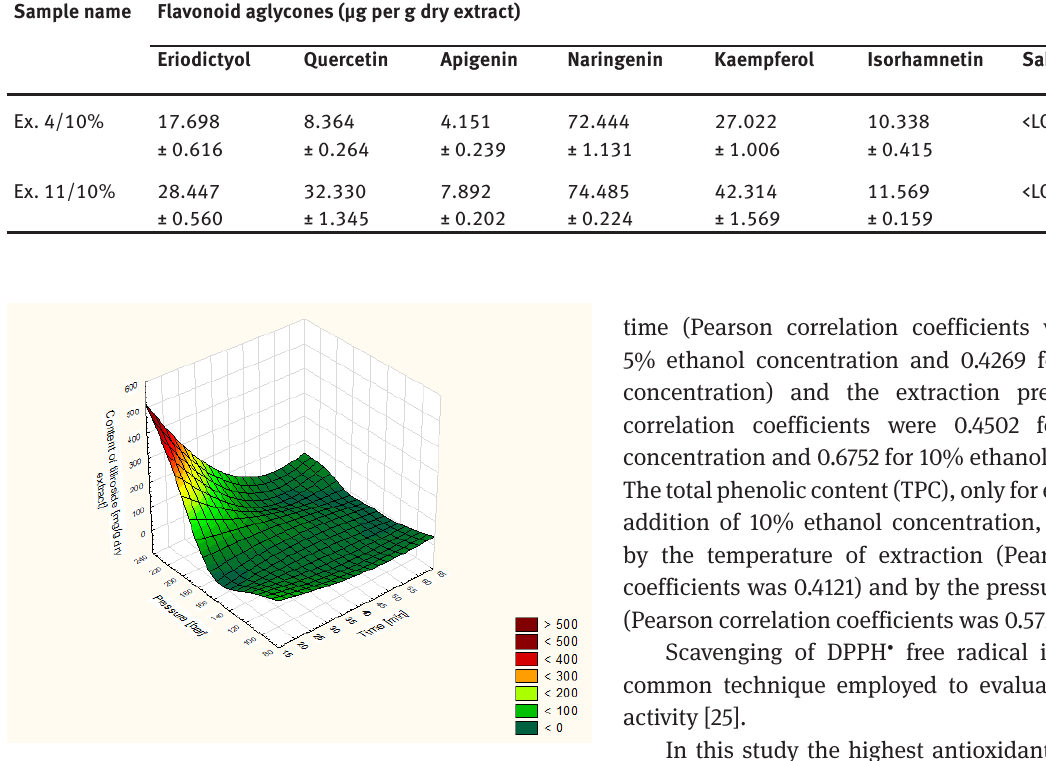
Figure 6: Surface chart 3W of the content of tiliroside vs. time and pressure of extraction (for 10% ethanol concentration) (Smoothing of smallest squares weighted by distance).